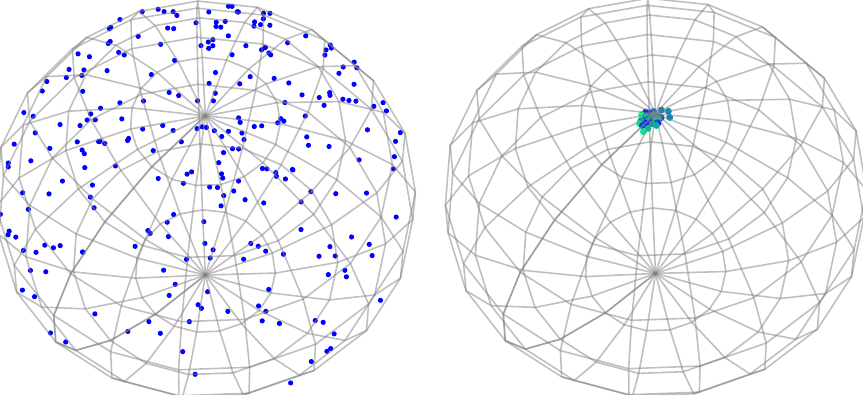
Figure 4. ( left ) 256 sampled data points on S 2 (north pole being population mean). ( right ) 32 samples of the diffusion mean conditioned on the diagonal of ( S 2 ) n , n = 256, T = 0.2. As can be seen, the variation in the mean samples is